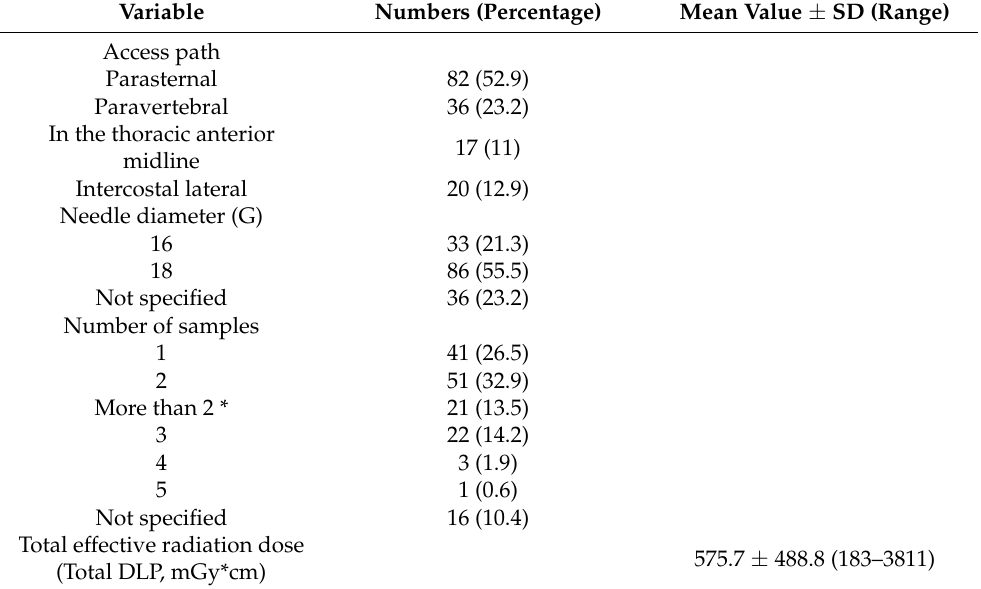
Table 2. Characteristics and technical outcome of CT-fluoroscopy-guided percutaneous core needle biopsy of 155 mediastinal